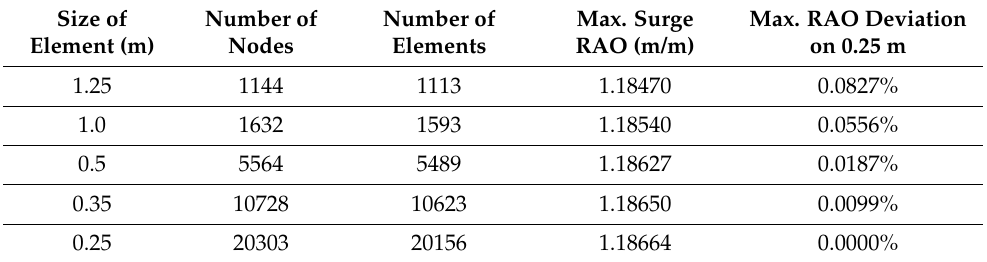
Table 11. Mesh Grid independence for Surge Study using diffraction